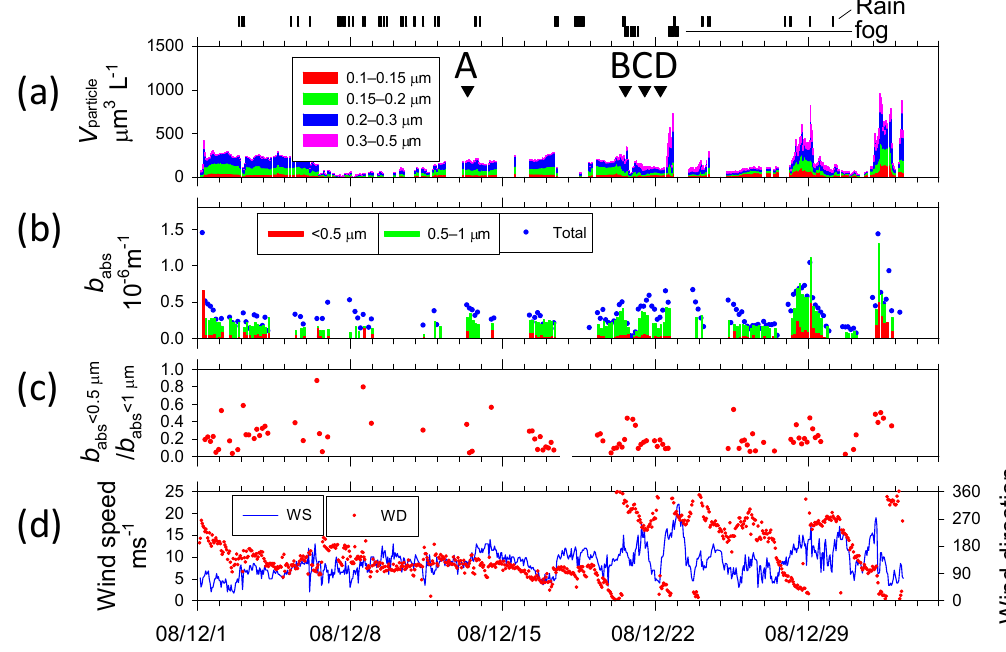
Figure 4. Temporal variations of (a) volume concentration of aerosol particles and start times of TEM sampling (A–M with arrows), (b) ab- sorption coefficient b abs of size-segregated aerosols, (c) ratio of b abs of < 0.5µm to b abs of < 1.0µm particles, and (d) wind speed and direction from Benoa to Cape Town. Vertical marks above (a) show periods of rain and